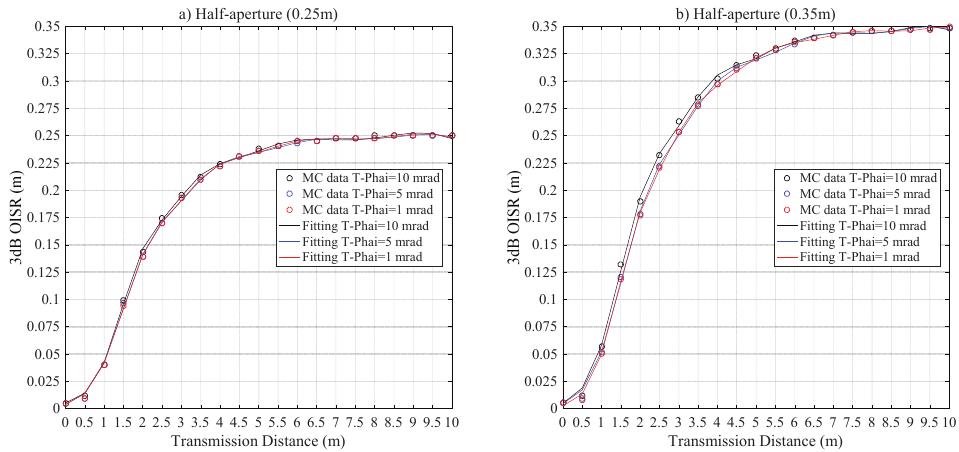
Figure 14. The r 3 dB versus Z 0 for the harbor seawater laser channel for a half-aperture of ( a ) R PD = 0.25 m and ( b ) R PD = 0.35